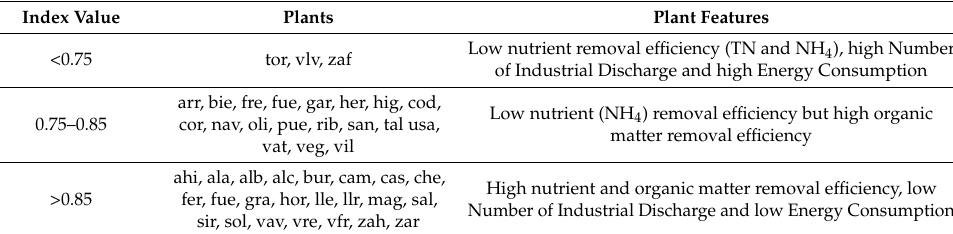
Figure 6. Sustainability Index for each one of the plants studied. Table 8. Summary of Sustainability Index .